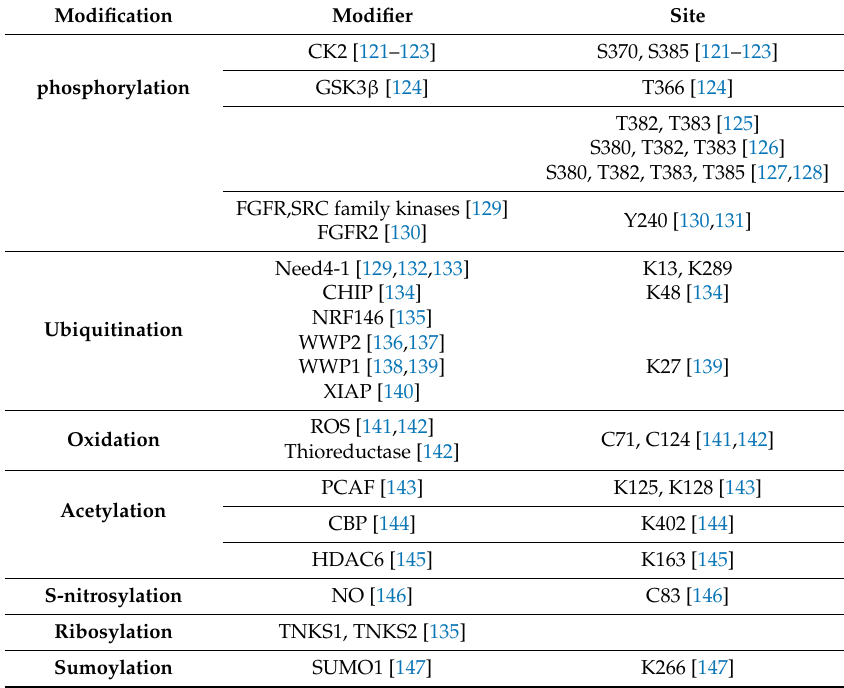
Table 1. Post-translational modifications of